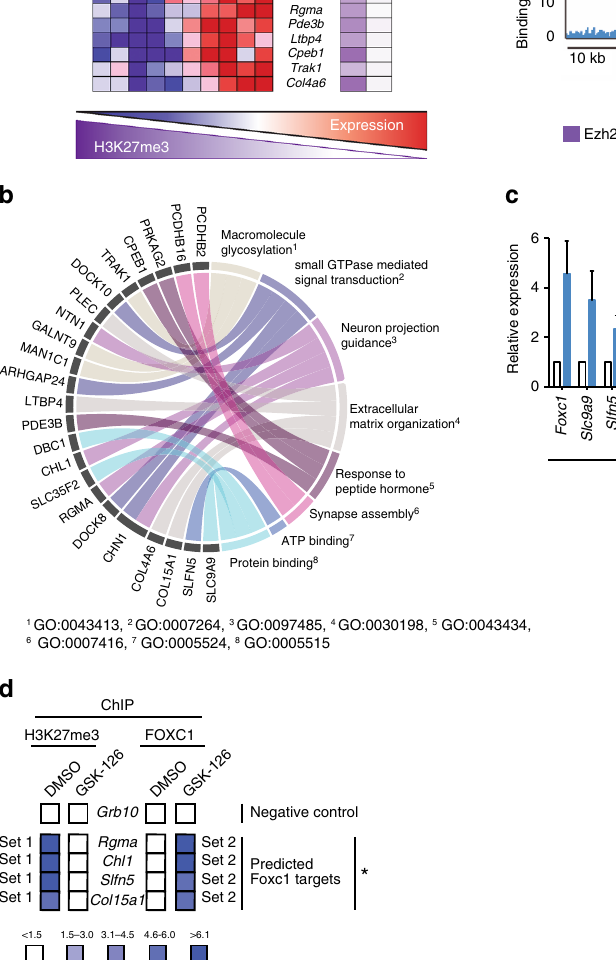
subtype. First, we treated a panel of human breast cancer cell lines representing four different molecular subtypes with GSK-126. Subsequent analysis of transcript levels demonstrated that only the Luminal B cell lines showed signi fi cant upregulation of